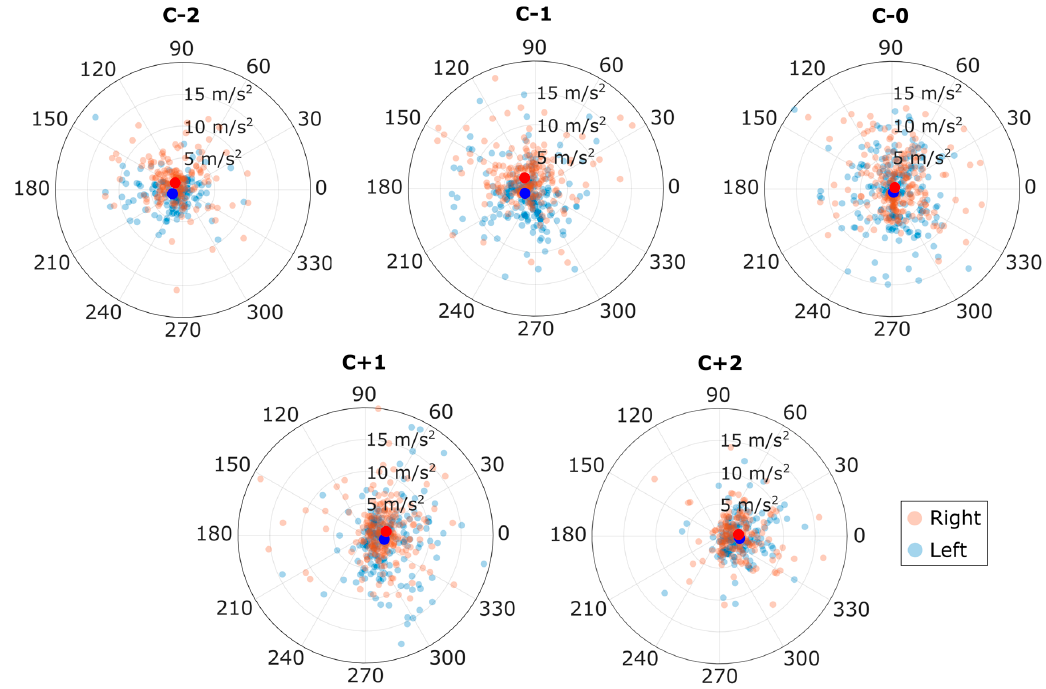
Figure 8. Footfall accelerations for each cutting footfall. The zero-degree direction was defined as the player’s local forward axis ( + X); the 90 ◦ line ( + Y) is to the player’s left. The solid blue and red dots represent the mean left and right accelerations, respectively. The polar axes are restricted to 20 m / s magnitude to better show trends; 24 outlier footfalls are outside this view.